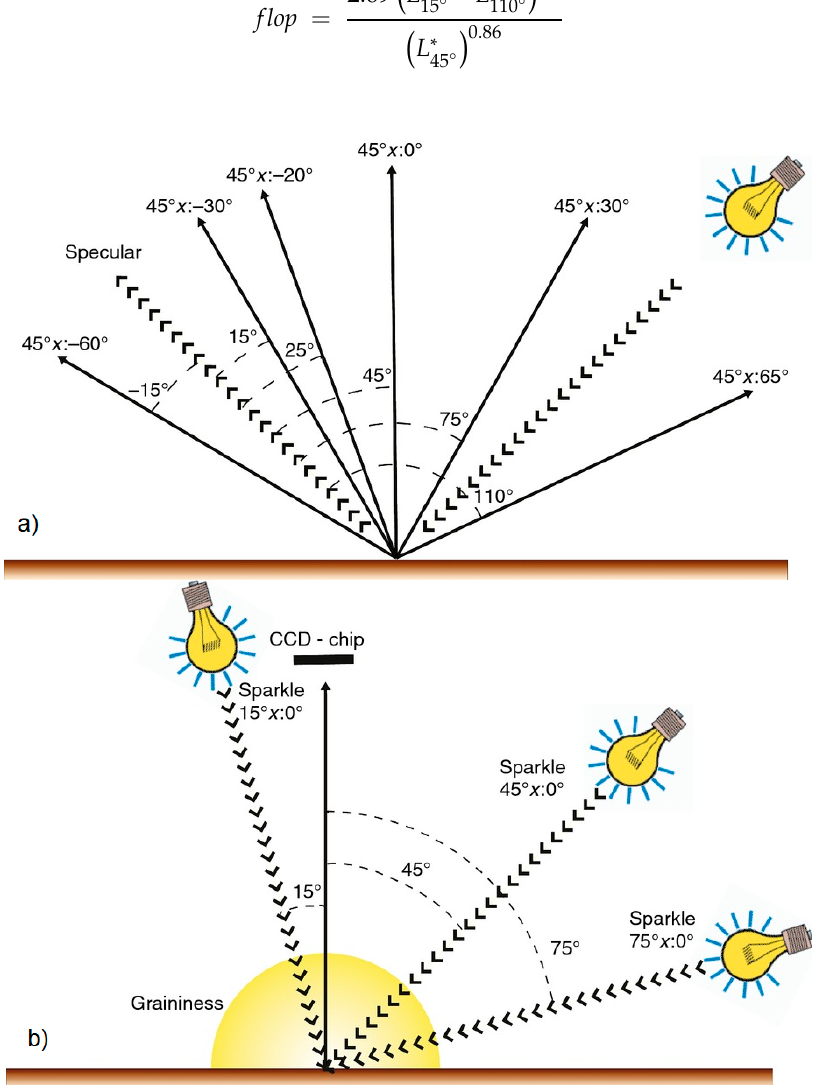
Figure 2. ( a ) Schematic representation of the illumination/measurement geometries used by the BYK-mac device for color characterization. ( b ) Schematic representation of the illumination/measurement geometries used with the BYK-mac device for sparkle and graininess characterization [24].